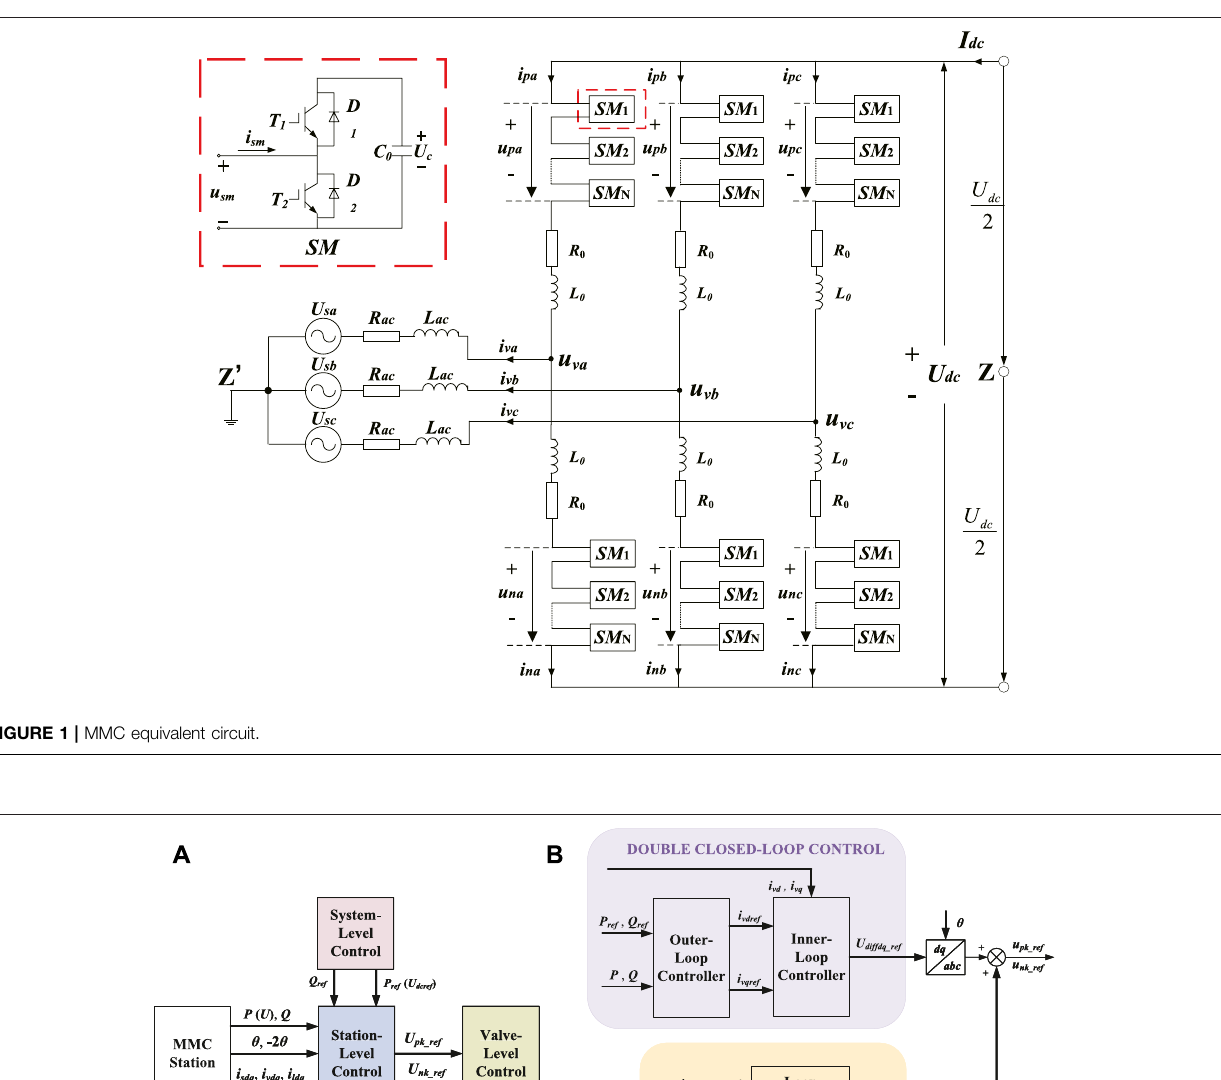
FIGURE 2 | Block diagram of overall control architecture, (A) block diagram of three control levels of MMC, (B) detailed station-level control of MMC.